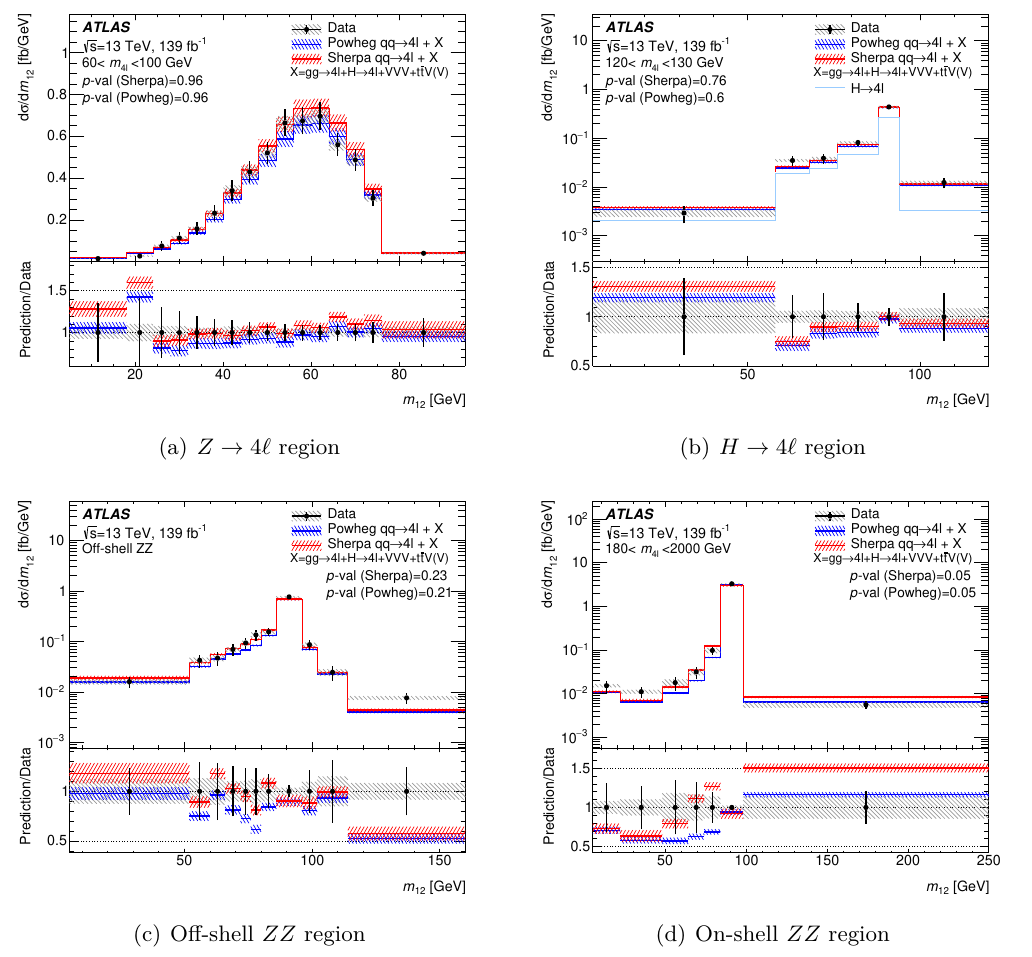
Figure 6 . Differential cross-section as a function of m 12 in the four m 4 ‘ regions. The measured data (black points) are compared with the SM prediction using either Sherpa (red, with red hashed band for the uncertainty) or Powheg + Pythia8 (blue, with blue hashed band for the uncertainty) to model the q ¯ q → 4 ‘ contribution. In (b) the contribution from Higgs production is shown in addition to the total SM prediction. The error bars on the data points give the total uncertainty and the grey hashed band gives the systematic uncertainty. The p -value is the probability for the χ 2 , with the number of degrees of freedom equal to the number of bins in the distribution, to have at least the observed value, given the SM prediction. The lower panel shows the ratio of the SM predictions to the